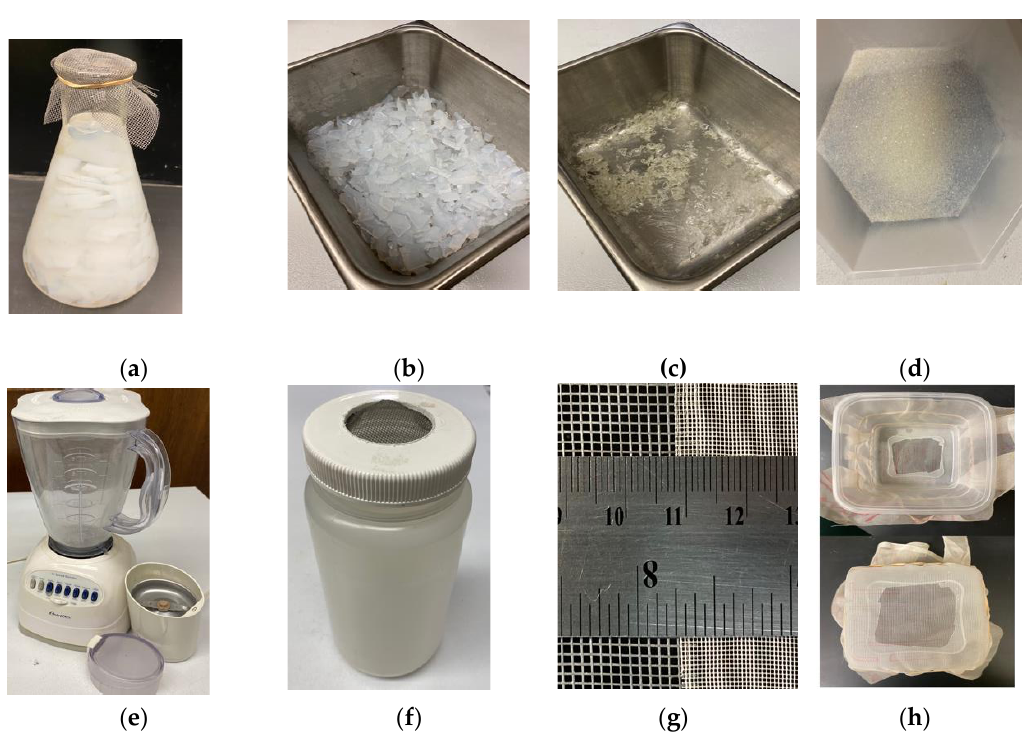
Figure 1. Processing of used agarose gels. ( a ) An Erlenmeyer flask with netting attached to the top allows for efficient removal of water from used gel slices. Gel slices are soaked in distilled water, then with ultrapure (Millipore, filtered) water, with one or more exchanges of water daily. ( b ) After freezing, chopping the gel into finer pieces, and another round of water leaching, gel slices are placed in a baking dish and baked at 55 – 60 °C until dehydrated; ( c ) depicts dried agarose flakes